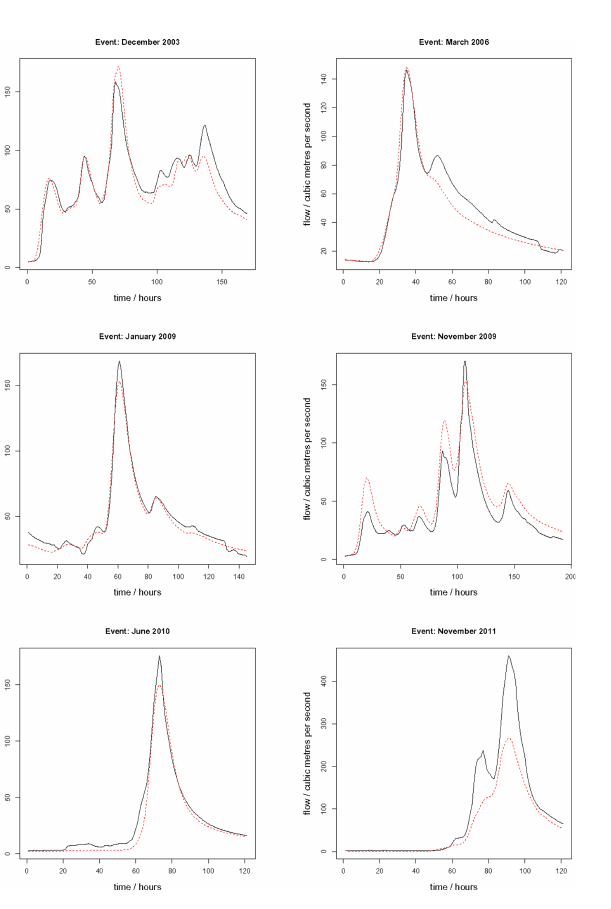
Fig. 11. Calibration plots for the distributed catchment model: com- parisons between observed (solid line) and fitted (dashed red line) hydrographs for the largest six events at the Aizarnazabal (B2Z1) site.